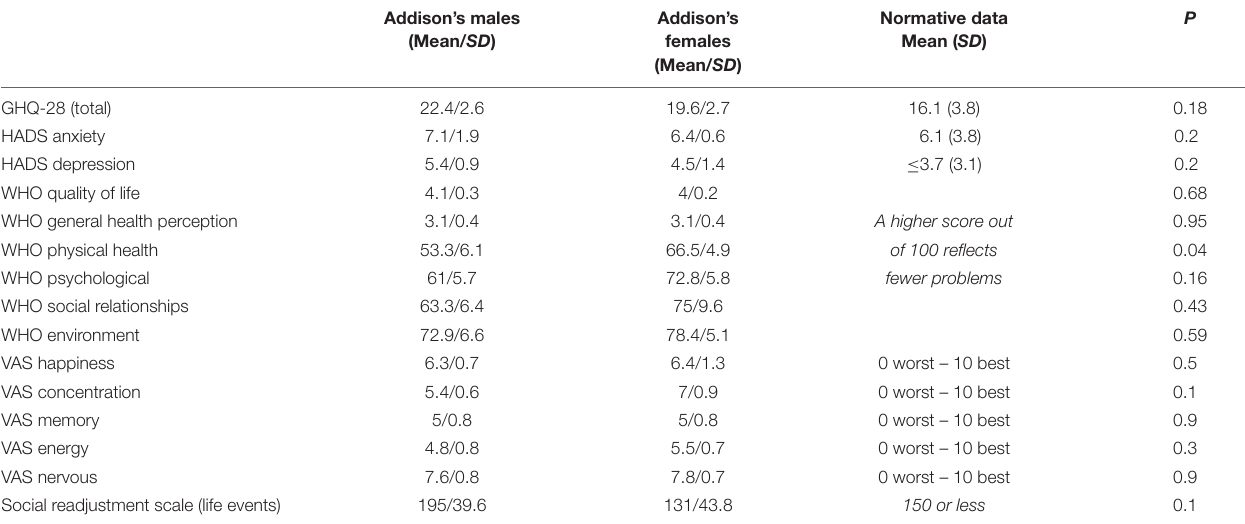
TABLE 3 | Comparison between males and females within the Addison’s patient group for mood and quality of life. Addison’s males (Mean/ SD